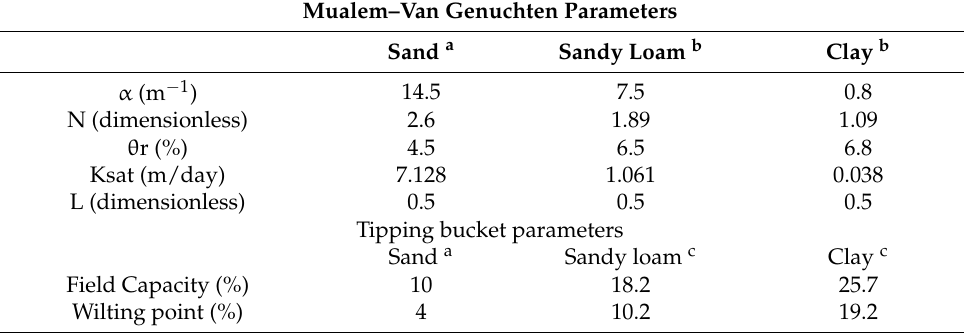
Table 4. Values of Mualem–Van Genuchten and tipping bucket parameters for three soil types used in the model